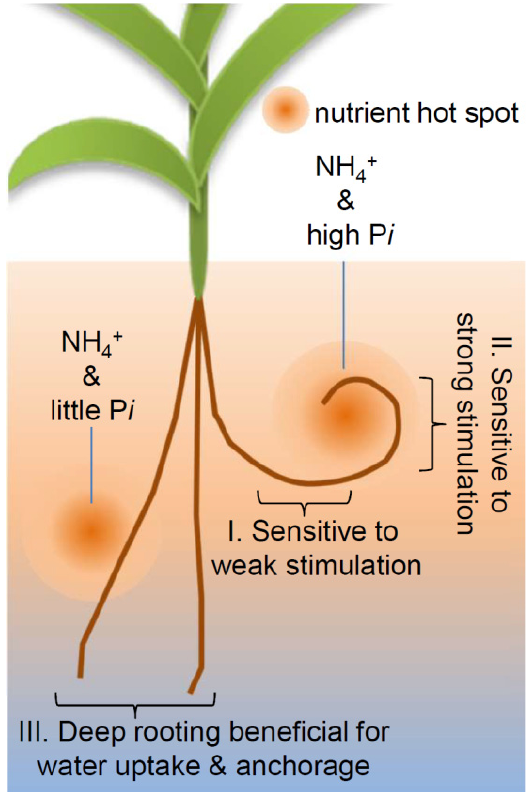
Figure 5. A hypothetical model of tropistic responses in a natural environment. I: when the root tips are exposed to nutrient gradients from a hot spot of NH 4+ and high P i , they can respond to weak stimulation by NH 4+ at a distance from the hot spot. II: as the root tips approach the hot spot, nutrient intensities become stronger. Increasing P i enables root tips to respond to the increasing intensities. III: when a hot spot contains NH 4+ but not P i , roots pass by them. In general, deep rooting through gravitropism enables plants to anchor themselves and to acquire water efficiently. Nutrient hot spots can be provided by